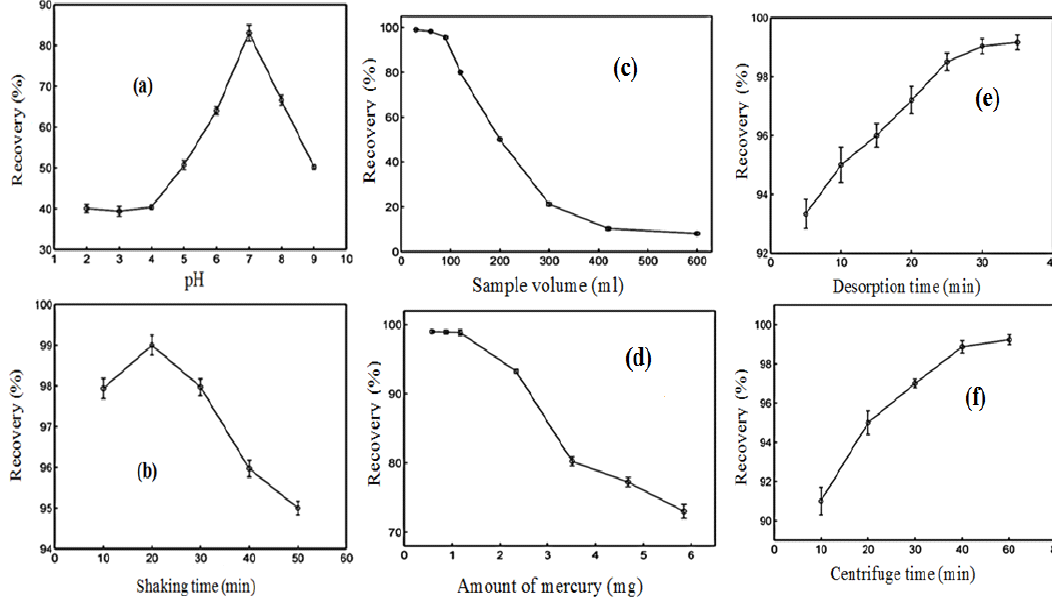
Fig. 2. Effect of (a) pH buffer solution, (b) shaking time, (c) sample volume, (d) initial metal ion concentration (adsorption capacity), (e) desorption time, and (f) centrifugation time on the recoveries of